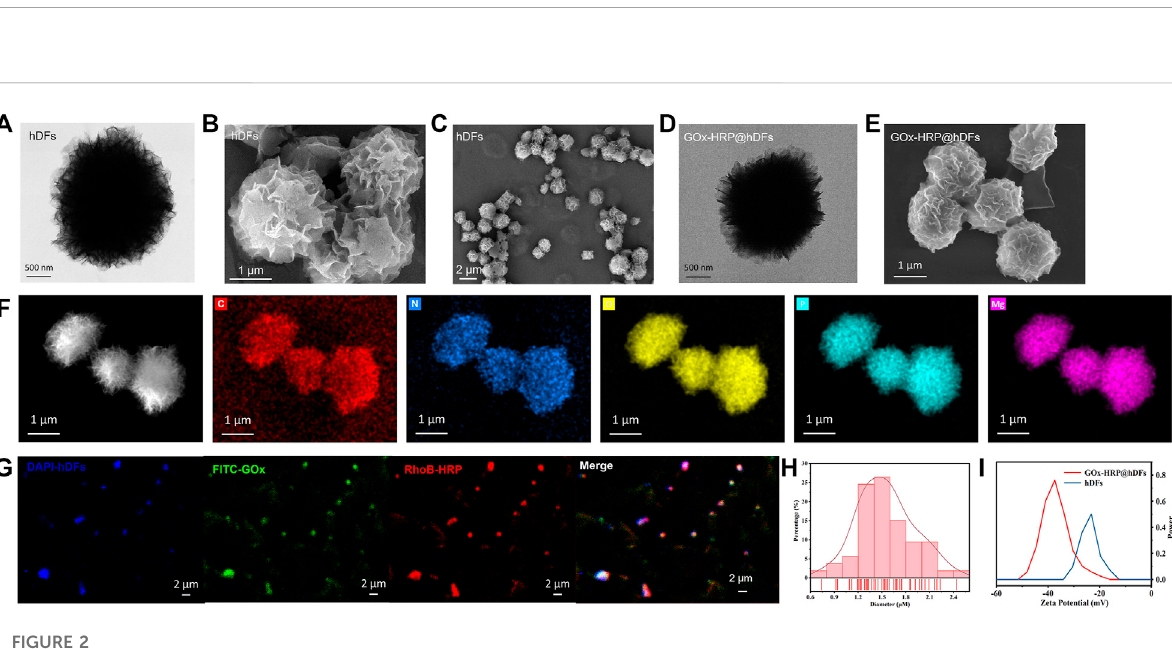
FIGURE 2 Morphology of the hDFs. (A) HAADF-STEM images of hDFs DNA hydrogel. (B,C) SEM images of hDFs. (D) HAADF-STEM images of GOx-HRP@ hDFs. (E) SEM images of GOx − HRP@hDFs. (F) EDS elemental mapping of hDFs (bright fi eld and elements: C, N, O, P, Mg in order). (G) Confocal laser scanning microscopy images of hDFs, on which GOx and HRP were simultaneously immobilized(GOx-HRP@hDFs). The GOx-HRP@hDFs, GOx and HRPwerelabeledwithDAPI(blue),FITC(green)andRhoB(red),respectively. (H) ParticlesizedistributionofhDFs. (I) ZetapotentialsofhDFsand